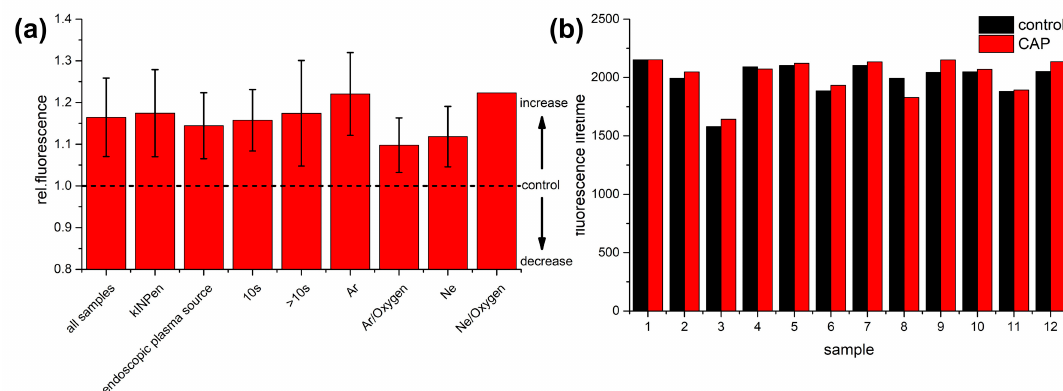
Figure 2. Multimodal nonlinear imaging of a human skin tissue sample before (panels a–d) and after cold atmospheric plasma (CAP) treatment for 20 s using the kINPen-device with an Ar–oxygen mixture (panel e). ( a ) TPEF image, excitation at 672.5 nm and 832.2 nm due to simultaneous CARS Figure 3. Results from two-photon time correlated single photon counting (TCSPC) fluorescence imaging using these wavelengths as pump and Stokes, emission 426–490 nm; ( b ) CARS image at Figure 4. Results from two-photon time correlated single photon counting (TCSPC) fluorescence measurements ( a ) The relative change of the total fluorescence (two-photon excitation at 672.5 nm 2850 cm − 1 ; ( c ) SHG image at 415 nm; ( d ) 2P-FLIM image for the same parameters as in ( a ) before CAP measurements ( a ) The relative change of the total fluorescence (two-photon excitation at 672.5 nm and 832.2 nm, corresponding to single photon excitation at 336 and 416 nm, fluorescence emission treatment, the green arrows mark melanocytes within the stratum basale; ( e ) 2P-FLIM image for the and 832.2 nm, corresponding to single photon excitation at 336 and 416 nm, fluorescence emission at at 426–490 nm) after CAP treatment is plotted for all samples normalized to the total fluorescence of same parameters as in ( a ) after 20 s of CAP treatment using the kINPen MED ® -device with an 426–490 nm) after CAP treatment is plotted for all samples normalized to the total fluorescence of the the control ( = 1.0), i.e., all measurements and experimental conditions (treatment time, plasma source, Ar–oxygen mixture revealing an overall increase in fluorescence, particularly in the melanocytes control (=1.0), i.e., all measurements and experimental conditions (treatment time, plasma source, gas gas composition, specimen), the two plasma devices kINPen MED ® (using Ar and an Ar–oxygen gas inside the stratum basale, indicated by green arrows; ( f ) brightfield microscopic image of AgNO 3 composition, specimen), the two plasma devices kINPen MED ® (using Ar and an Ar–oxygen gas mixture for operation and treatment times from 10–70 s) and the endoscopic plasma device (using staining for melanin proving localization of the CAP-induced increase of autofluorescence within the mixture for operation and treatment times from 10–70 s) and the endoscopic plasma device (using Ne Ne and a Ne–oxygen gas mixture for operation and treatment times of 10 and 60 s), treatment times melanocytes inside the stratum basale, marked by green arrows. ( g ) total fluorescence signal before and a Ne–oxygen gas mixture for operation and treatment times of 10 and 60 s), treatment times of of 10 s (in combination with di ff erent CAP devices and gas mixtures), longer treatment times (20 s, and after CAP treatment. The fluorescence intensity increases in this case by 2%, typically the increase 10 s (in combination with different CAP devices and gas mixtures), longer treatment times (20 s, 60 s 60 s and 70 s) and di ff erent gas mixtures. Here, Ar and Ar–oxygen gas mixtures were used with the is larger, see Figure 4a. and 70 s) and different gas mixtures. Here, Ar and Ar–oxygen gas mixtures were used with the kINPen-device only, Ne and Ne–oxygen gas mixtures were used with the endoscopic plasma device kINPen-device only, Ne and Ne–oxygen gas mixtures were used with the endoscopic plasma device only. ( b ) Change of the median fluorescence lifetime for the parameters of ( a ) for all samples under only. ( b ) Change of the median fluorescence lifetime for the parameters of ( a ) for all samples under investigation and all 12 experimental conditions using a monoexponential decay function and plotting investigation and all 12 experimental conditions using a monoexponential decay function and the median lifetime of the whole FLIM image. The experimental conditions are in detail: 1,2: Skin, 10 s plotting the median lifetime of the whole FLIM image. The experimental conditions are in detail: 1,2: kINPen, Ar gas; 3: Mucosa lesion, 10 s kINPen, Ar gas; 4: Mucosa, 10 s kINPen, Ar gas; 5,6: Skin, 10 s Skin, 10 s kINPen, Ar gas; 3: Mucosa lesion, 10 s kINPen, Ar gas; 4: Mucosa, 10 s kINPen, Ar gas; 5,6: Skin, 10 s kINPen, Ar–oxygen gas mixture; 7: Skin, 20 s kINPen, Ar–oxygen gas mixture; 8: Skin, 70 s kINPen, Ar gas; 9: Skin, 10 s endoscopic plasma source, Ne gas; 10,11: Skin, 1 min endoscopic plasma source, Ne gas; 12: Skin, 1 min endoscopic plasma source, Ne–oxygen gas. In eight cases a lifetime increase was observed, while in four cases the fluorescence lifetime was reduced.